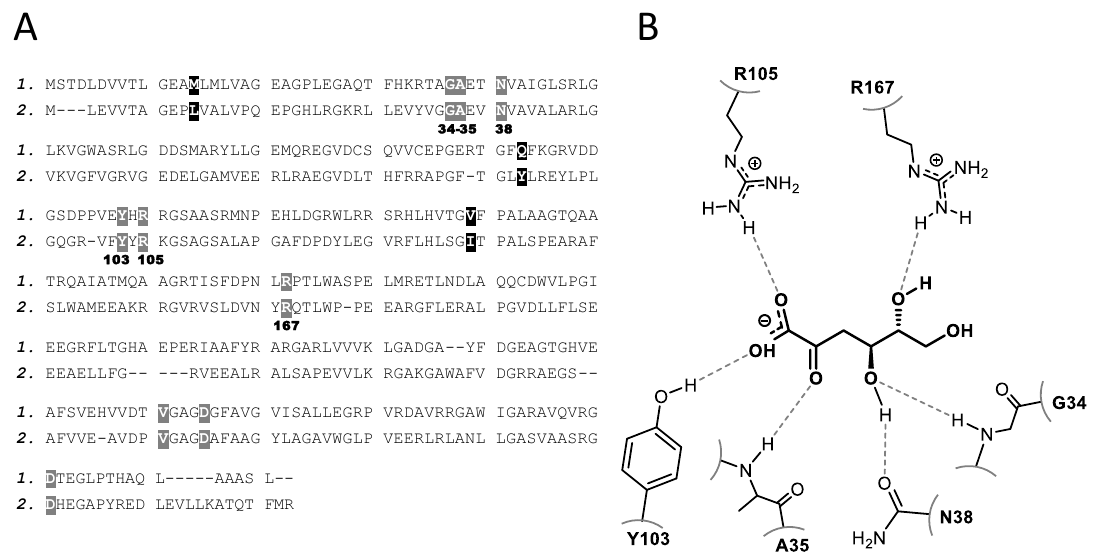
Figure 5. Sequence alignments and substrate accommodations of the concerned residues. ( A ) Amino acid sequence alignments of KGUK from C. necator (1.) and 2-keto-3-deoxy- D -gluconate kinase (KDGK) from Thermus thermophilus (2.) . Grey-shaded amino acids have been identified as active site residues in the crystallographic structure of the KDGK enzyme. Only three residues (shaded in black) are different in the C. necator enzyme. ( B ) Structure of the active site of KDGK from T. thermophilus.